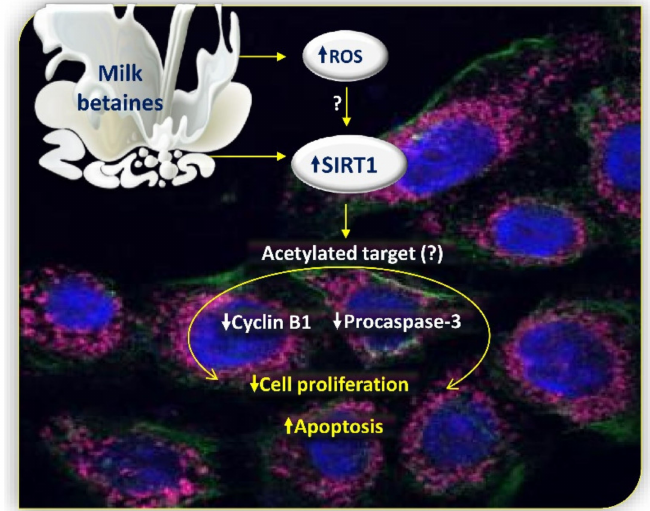
Figure 8. Schematic representation of cellular events induced by milk betaines in Cal 27 cells. Dietary betaines, δ VB and γ BB, cause inhibition of cell proliferation and induction of apoptosis. Pure